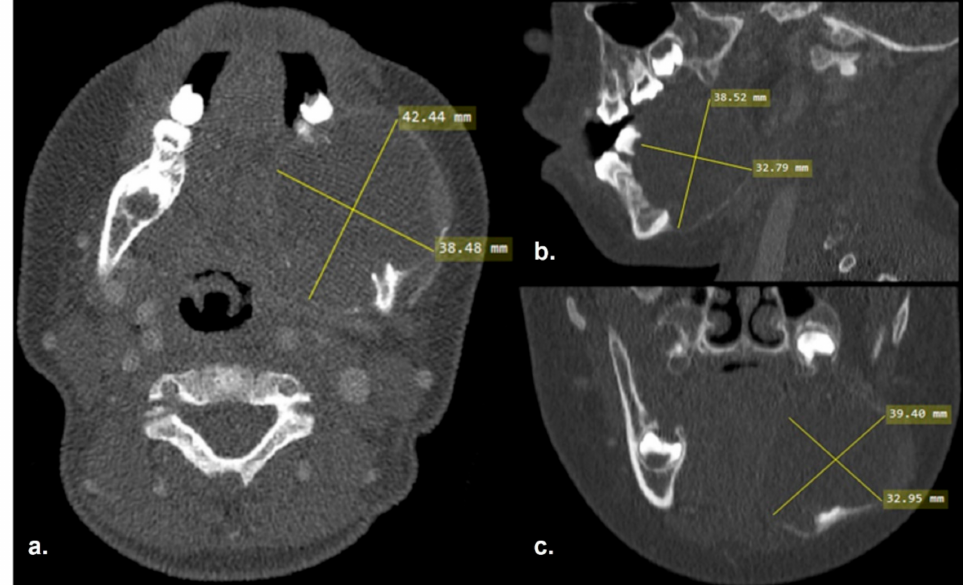
Figure 2. Pre-operative contrast facial computed tomography (CT) with multiplanar reconstructions showing a well-demarcated, multilocular radiolucent lesion in the left posterior mandible surrounded by a radiopaque border. The marked expansion and thinning of the buccal and lingual cortices of bone, partially eroded, and the roots resorption of the first erupted molar and the second molar germ are evident. ( a ) Axial view; ( b ) sagittal view; ( c ) coronal view.